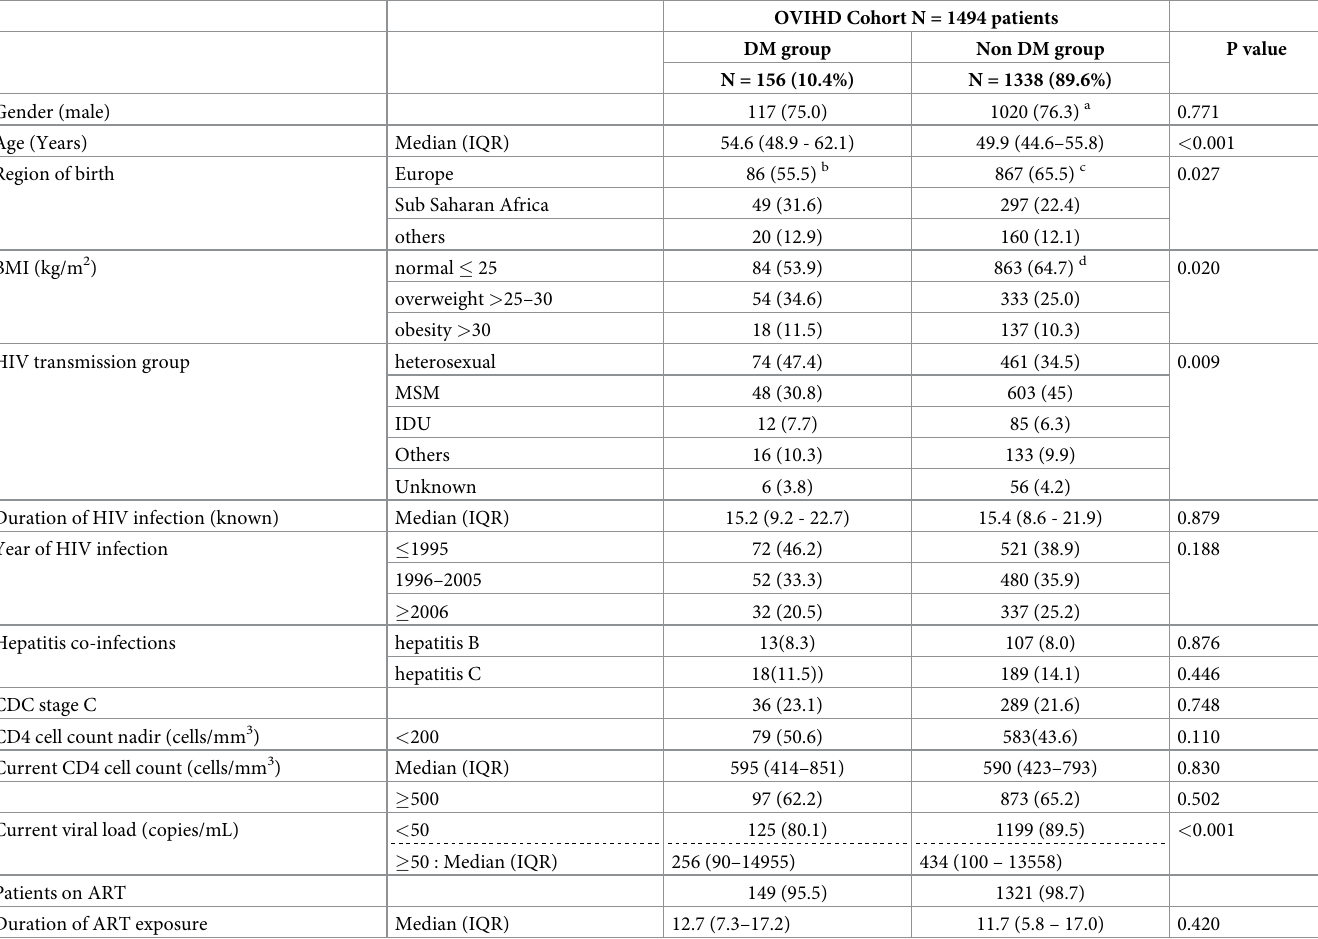
Table 1. Characteristics of the study population at